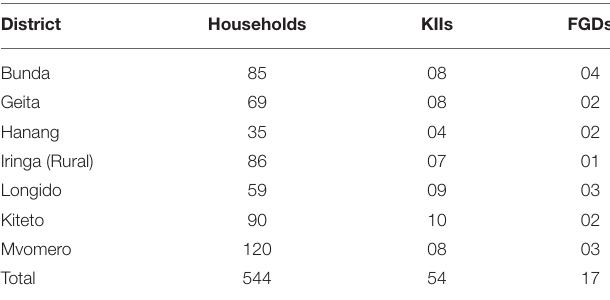
TABLE 2 | Study respondents by type of data collection method and